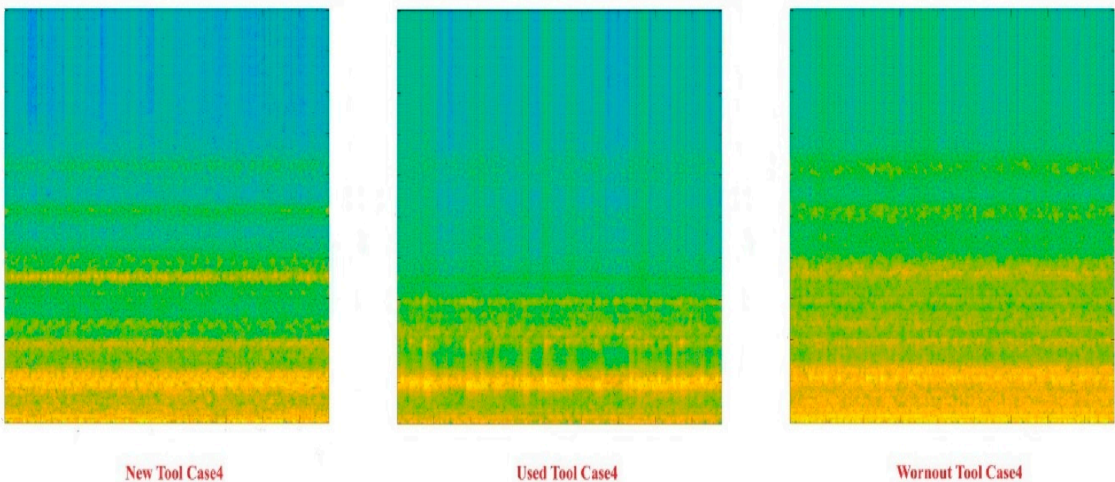
Figure 25. Spectrograms (training samples) of new, used, and worn-out tool conditions for Case 4.